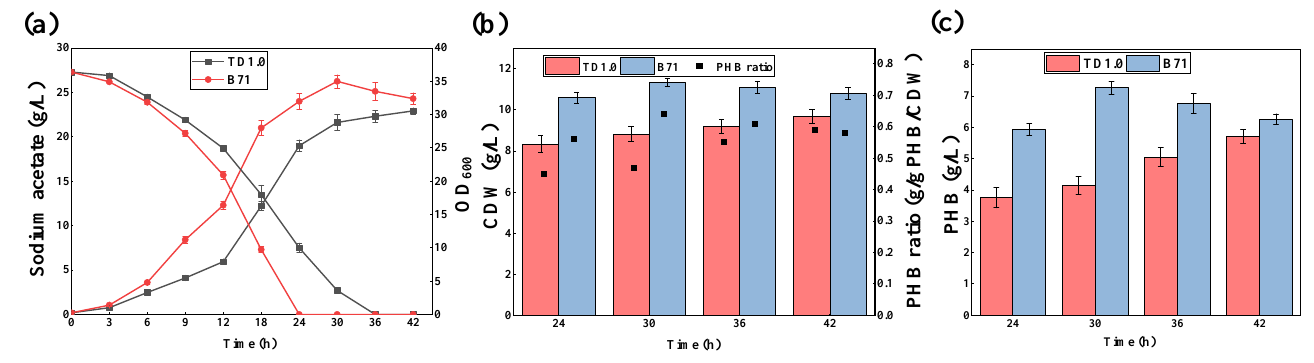
Figure 3. Comparison of growth, acetate utilization, and PHB production of TD1.0 and B71. Strains were grown in 60 MMA minimal medium containing 27.3 g/L sodium acetate. ( a ) Acetate concen- tration and OD 600 . ( b ) CDW and PHB ratio. ( c ) PHB production. Error bars represent standard de- viation (SD), n = 3.